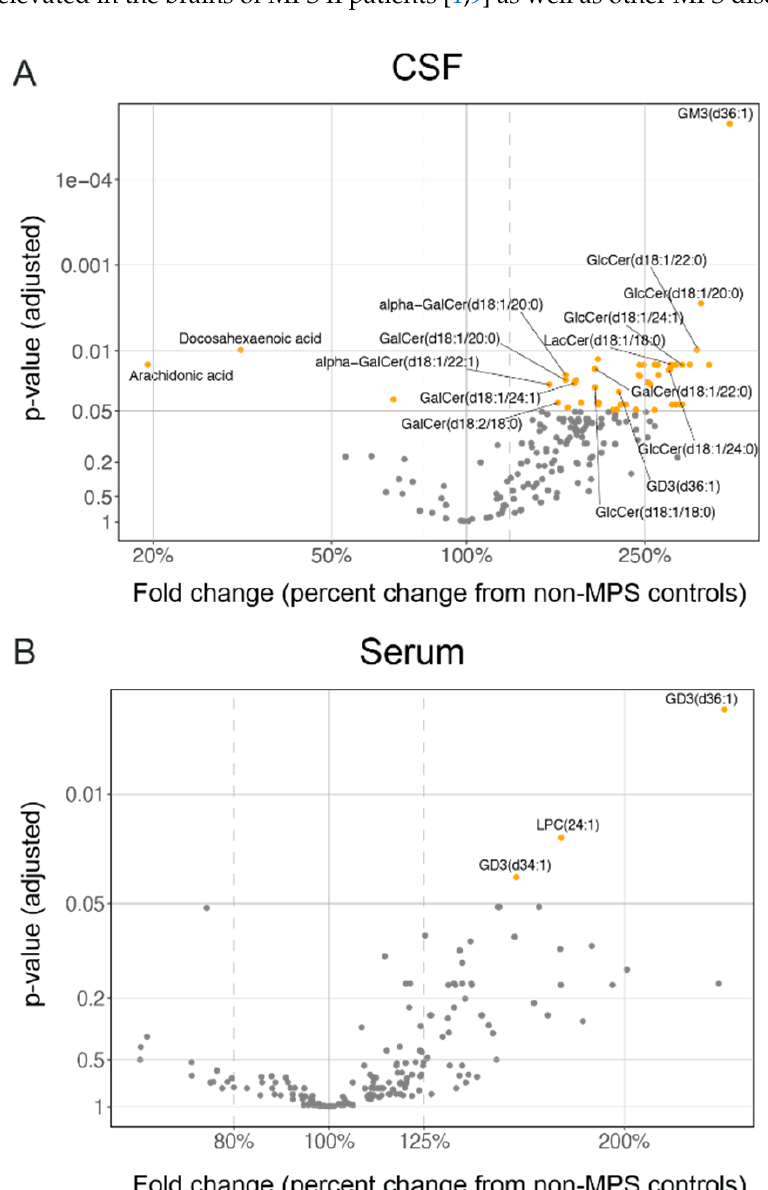
Figure 6. Exploratory lipidomic analysis in CSF and serum shows an accumulation of lysosomal lipids in the CSF of nMPS II patients relative to non-MPS controls. A volcano plot of lipid species in ( A ) CSF and ( B ) serum is shown. Changes in MPS II are depicted as % of non-MPS controls. Values above 100% imply an increase, while values below 100% imply a decrease from non-MPS controls. Di ff erences between nMPS II and non-MPS controls are estimated using a linear mixed-e ff ects model to account for subjects with repeated measures (2 MPS II patients on HSCT). Due to the exploratory nature of the analysis, age was adjusted as a linear e ff ect across all analytes. The treatment e ff ect was not considered due to the small number of patients with HSCT. P values are adjusted for multiple comparisons across all measurable analytes using the Benjamin-Hochberg